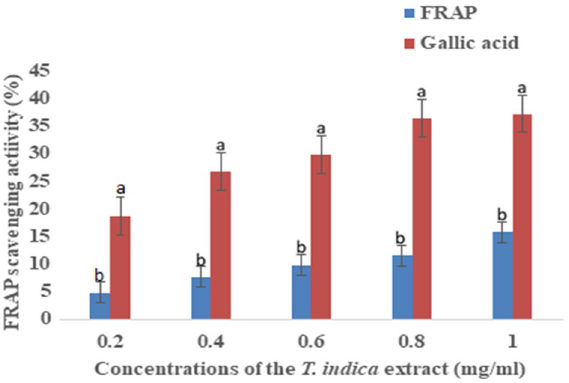
Figure 3. FRAP activity (%) (Mean + Standard deviation) of the extract of T. indica fruits.